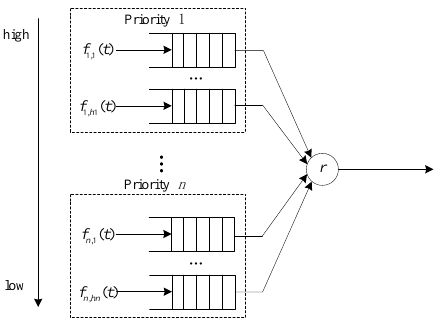
Figure 1: Hybrid Scheduling Model.